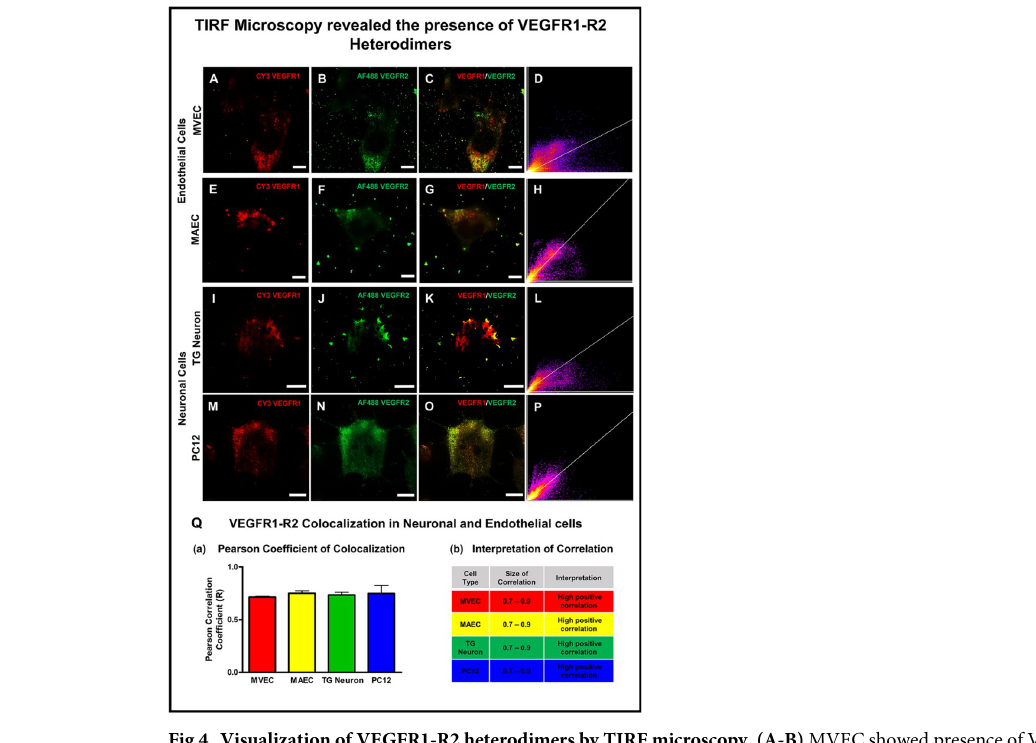
Fig 4. Visualization of VEGFR1-R2 heterodimers by TIRF microscopy. (A-B) MVEC showed presence of VEGFR1 and VEGFR2 surface receptors observed as red and green fluorescent signals respectively (C-D) Merged image and linear graph showing positive VEGFR1-R2 colocalization (E-F) MAEC exhibiting VEGFR1 and VEGFR2 immunostaining (G-H) Merged image and receptor colocalization graph confirmed VEGFR1-R2 heterodimer presence (I-J) Expression of VEGFR1 and VEGFR2 surface receptors in trigeminal ganglion neuronal cells (K-L) Merged image depicting heterodimer presence and colocalization graph confirming the same (M-N) PC12 neuronal cells exhibited VEGFR1 (fluorescent red punctate staining) and VEGFR2 (fluorescent green puncta) surface receptors (O-P) VEGFR1-R2 heterodimers visualized as yellowish-orange fluorescence and graph showing colocalization between the 2 channels (Q) Pearson Correlation Coefficient values were high positive for neuronal and endothelial cells indicating strong colocalization and evidence of receptor heterodimers. Coefficient of 0.7333 ± 0.0264 and 0.7480 ± 0.0763 (Mean ± SEM; n = 5) respectively, a strong indicator of VEGFR1-R2 heterodimer presence.